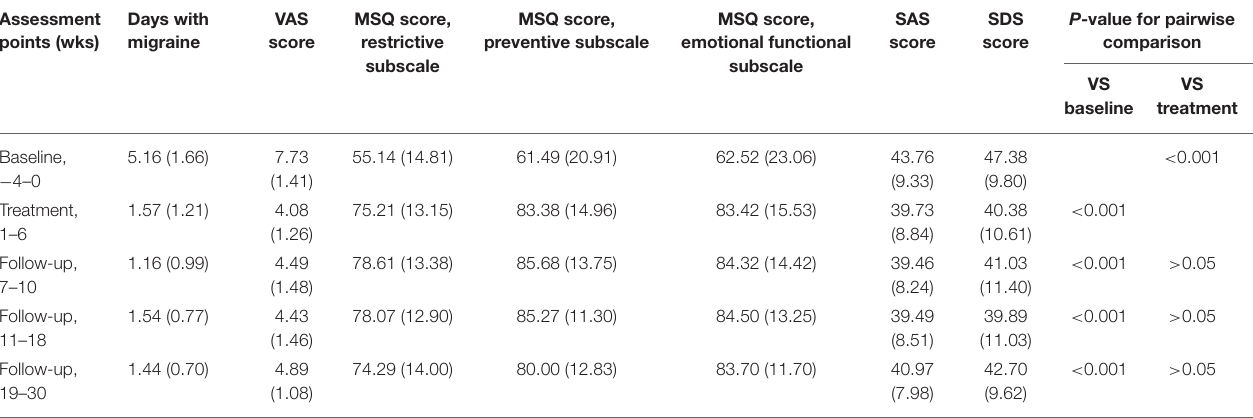
TABLE 2 | Clinical outcomes in patients with migraine without aura during the study period. Assessment points (wks)